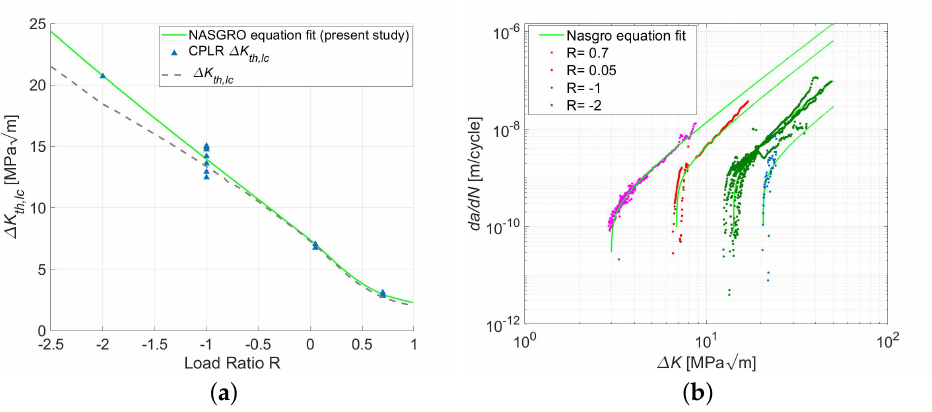
Figure 5. Fatigue crack growth characterization of the present EA4T steel: ( a ) Evaluated R- dependence of long crack thresholds ∆ K th , lc (values acquired from [42]) and comparison with the available data in literature [40] and ( b ) crack growth curves and interpolation with the Nas- gro